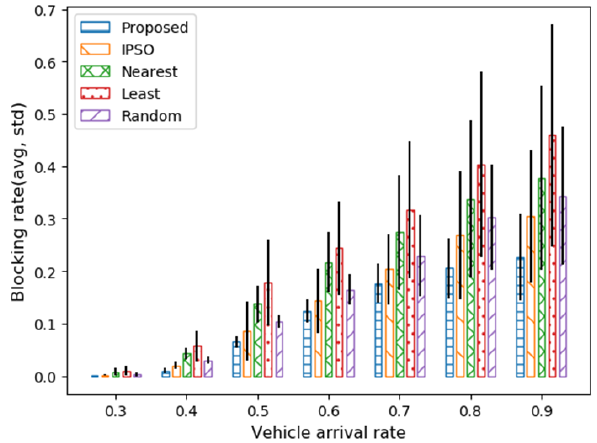
Figure 9. Load variance among MECSs of the five methods; ( a ) vehicle arrival rate = 0.3.; ( b ) vehicle arrival rate = 0.6; ( c ) vehicle arrival rate = 0.9.